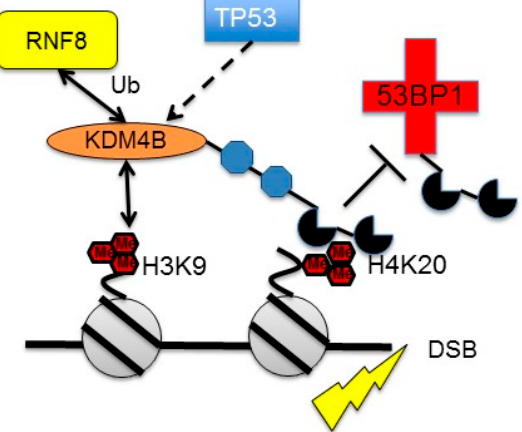
Figure 3. KDM4B influences DNA repair mechanisms. KDM4B is directly induced by p53. The Tandem Tudor domains target KDM4B to H4K20me3/2 at sites of DNA damage. This recruitment blocks